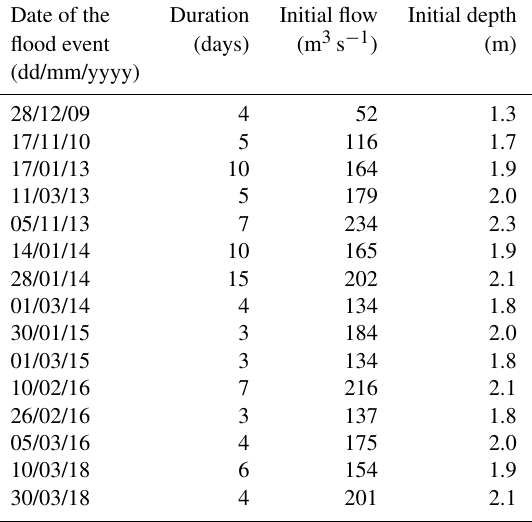
Table 4. Main characteristics of the analysed flood